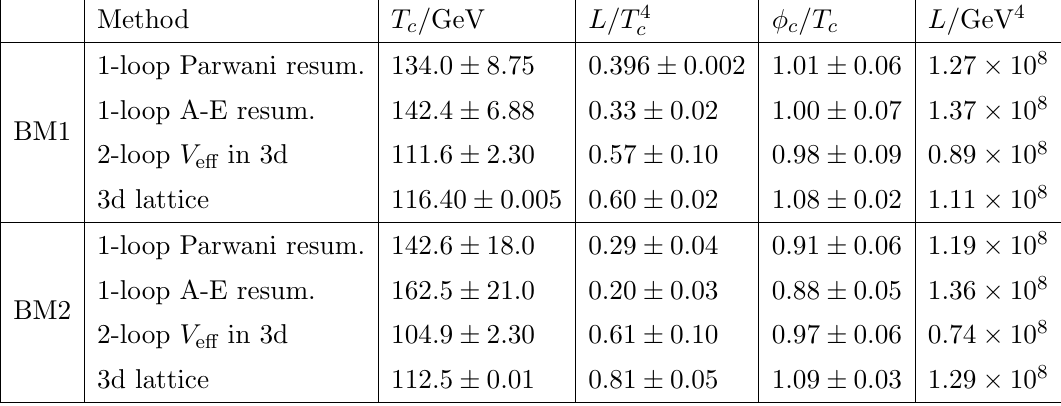
Table 5. Comparison of thermodynamic quantities as obtained either with the EFT approach, or with the resummed 1-loop potential in the full theory. Error bars indicate sensitivity to the RG- scale as described in the text. For the lattice results we show the statistical uncertainty. Numbers in the last column correspond to central values without scale uncertainties.